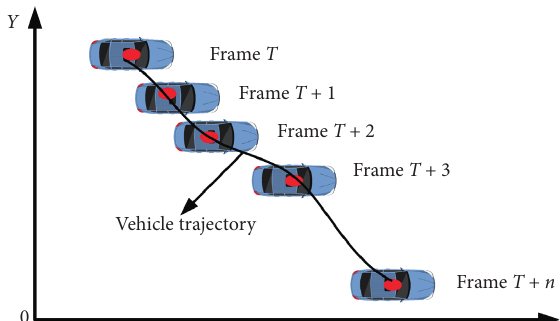
Figure 10: A schematic diagram of the formation of the trajectory of the vehicle steering